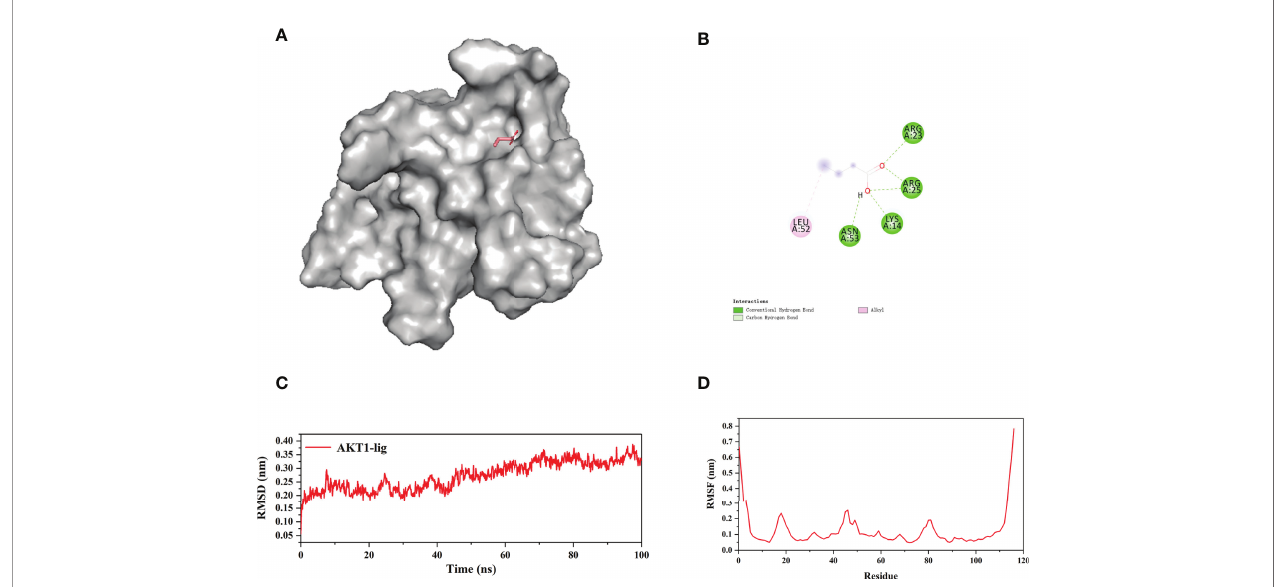
FIGURE 14 | 100 ns molecular dynamic simulations of AKT1-NaB using the GROMACS software. (A) The 3D stereoscopic molecular map of AKT1 and NaB docking. (B) 2D display of water and hydrogen bond docking between AKT1 and NaB. (C) RMSD and (D) the RMSF of molecular dynamic simulations. NaB, sodium butyrate.